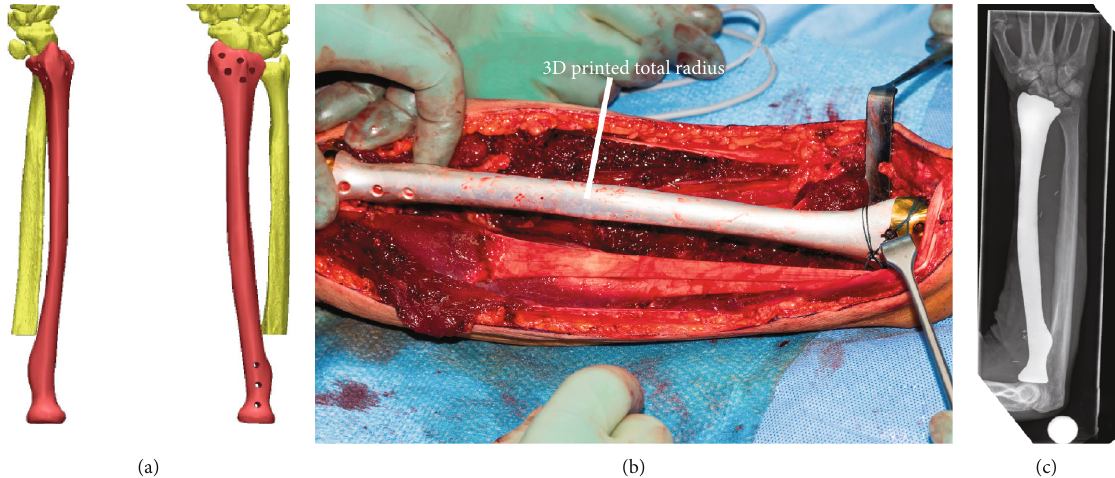
Figure 2: A 53-year-old man with a dedi ff erentiated leiomyosarcoma of the radius. (a) Virtual three-dimensional model of the radius. (b) Reconstruction with the 3D printed total radius. (c) X-ray image almost one year after